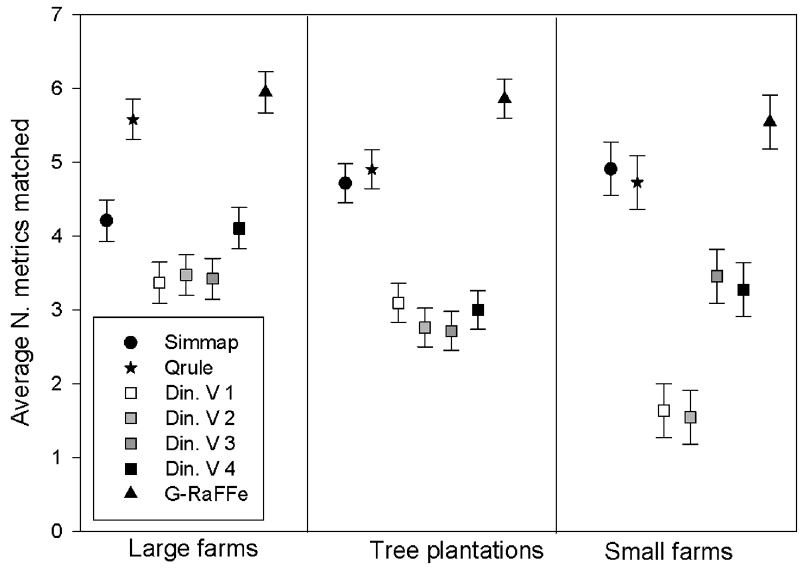
Figure 7. Effect of dominant land-use type on landscape simulator performance. Values represent the average number of landscape metrics that were simultaneously matched ( 6 SE). Din. V= Dinamica version.